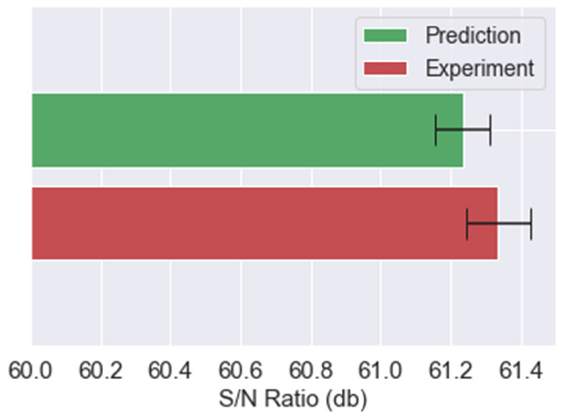
Figure 4. Tensile strength with 95% confidence interval.